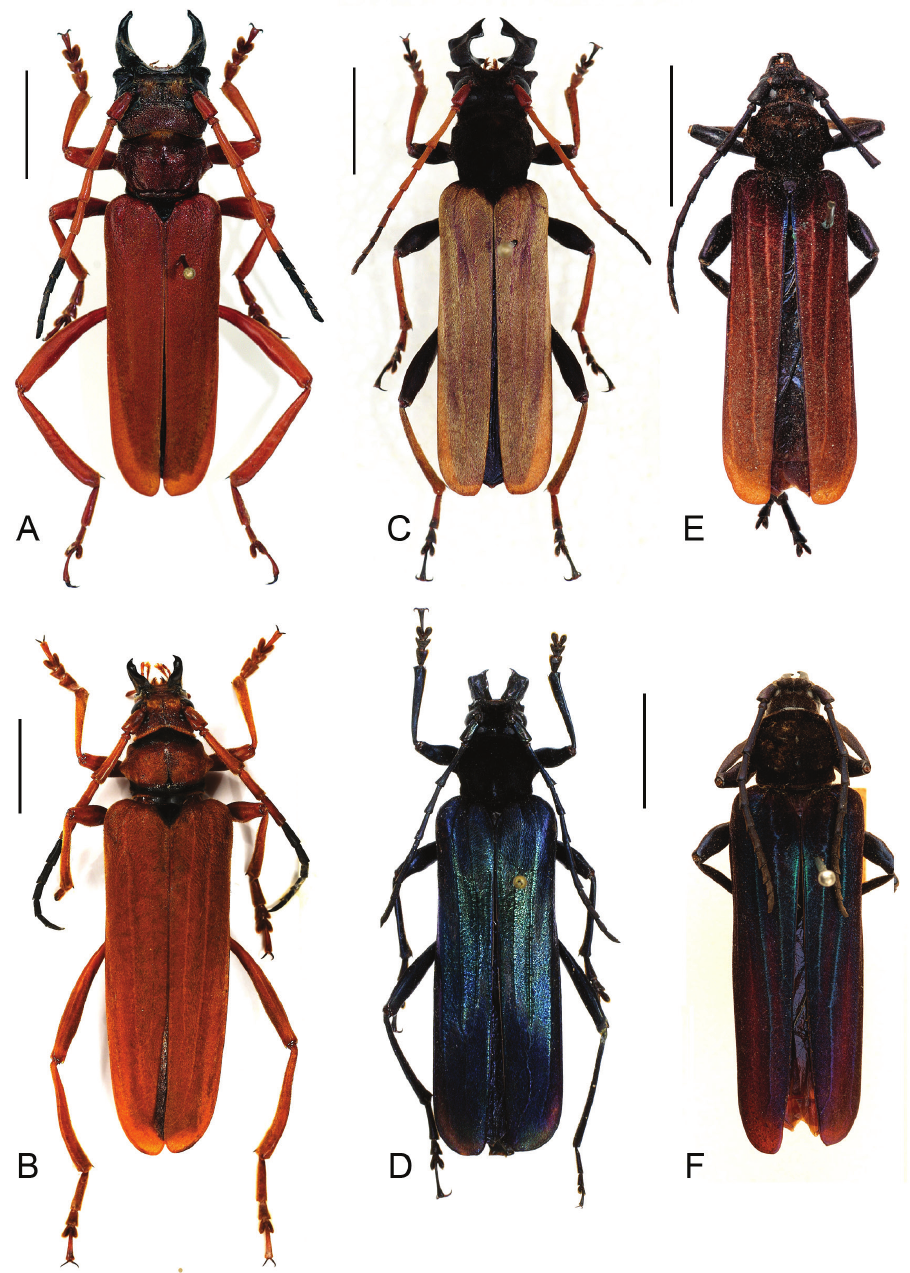
Figure 1. Dorsal view habitus, scale bars 10 mm A Parandrocephalus eversor , male, Malaysia, Cameron Highlands, Kampong Rajah B idem, female C Hexamitodera ( Sulcognatha ) blairi comb. n., male, Indone- sia, Central Sulawesi, Puncak D idem, female, allotype, Indonesia, Sulawesi, Palolo Palu e Hexamitodera semivelutina , male, Sulawesi F , idem, female, holotype, Indonesia, North